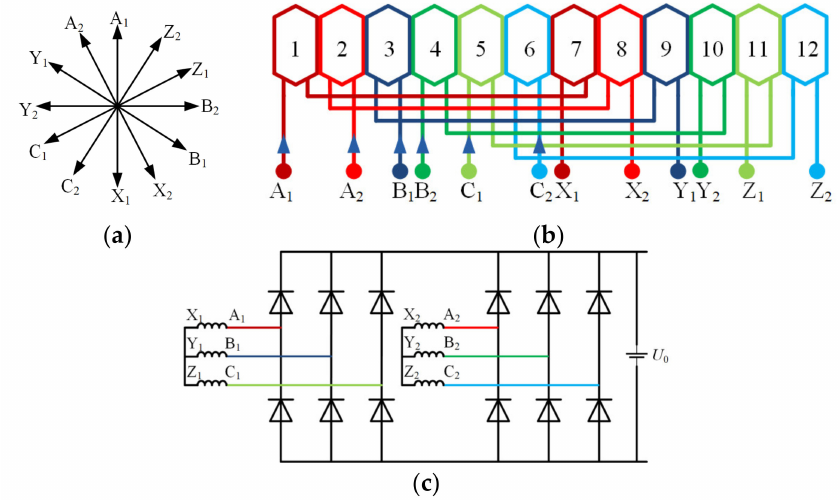
Figure 3. Armature winding and circuit diagram: ( a ) slot star diagram of armature winding; ( b ) ar- mature winding connection layout; ( c ) schematic diagram of rectifier